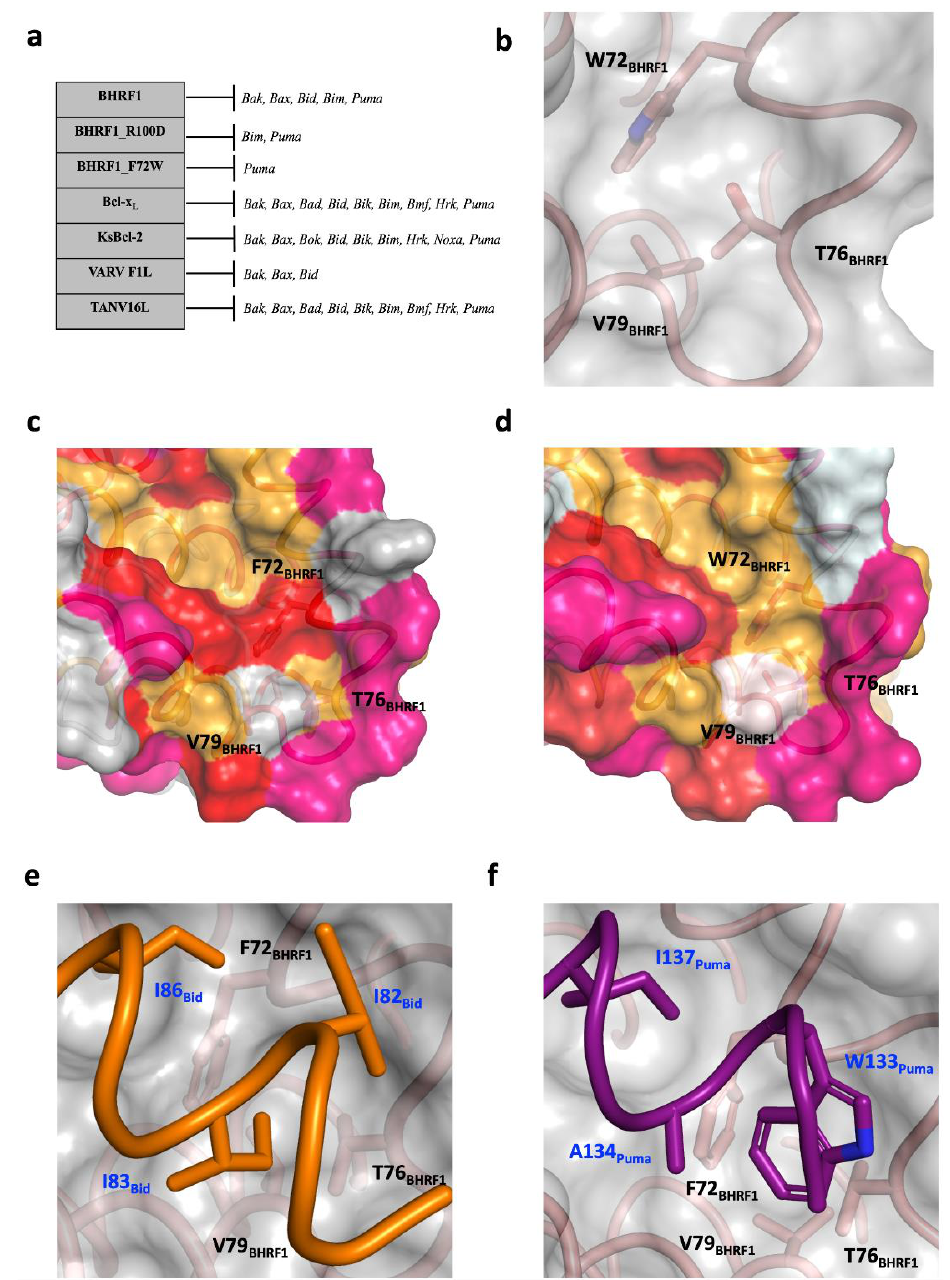
Figure 3. Interaction profiles and detailed view of the fifth hydrophobic pocket of BHRF1. ( a ) Sum- mary of BH3 interaction profiles of BHRF1, BHRF1 R100D, and BHRF1 F72W mutant and its closely related Bcl-2 homologs, human Bcl-x L, KSHV KsBcl-2, VARV F1L, and tanapoxvirus TANV16L. ( b ) Enlarged view of the additional hydrophobic pocket (fifth pocket) in the AlphaFold structure of F72W BHRF1 ( c ) View of the fifth pocket in BHRF1 – BidBH3 with the ligand removed and colored according to residue hydrophobicity; selected residues of BHRF1 are labeled. ( d ) An identical view of F72W BHRF1 as in ( c ). The surface, hydrophobic pockets of the binding groove, and key residues are indicated. In ( c , d ), the surface is colored according to residue hydrophobicity: red: F, V, L, I, M; orange: W, Y, C, A, G, P, S, T; pink: N, E, H; gray: Q, R, K, D. ( e ) View of the fifth pocket in BHRF1 – BidBH3. The surface of the BHRF1 is shown in gray with side-chains of the key hydrophobic residues located in the pocket shown as sticks. The BHRF1 backbone (salmon) and BidBH3 backbone (orange) are shown as tubes. Selected residues of Bid and BHRF1 are labeled. ( f ) Similar to ( e ), a view of the fifth hydrophobic pocket of BHRF1 – Puma BH3 (purple).